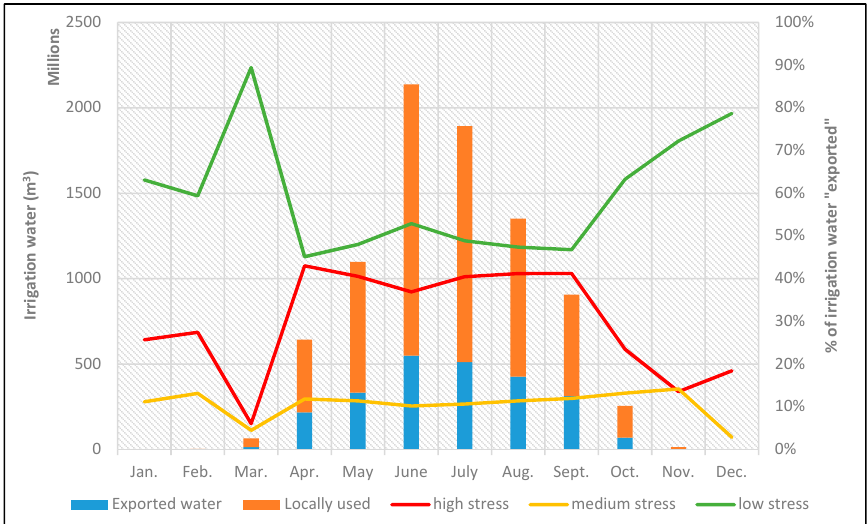
Figure 3. The amount of irrigation water consumed in Greek territory (locally used) against exported through trade and the percentage contribution to the exported water downscaled to low-, highly and medially stressed RBD areas.